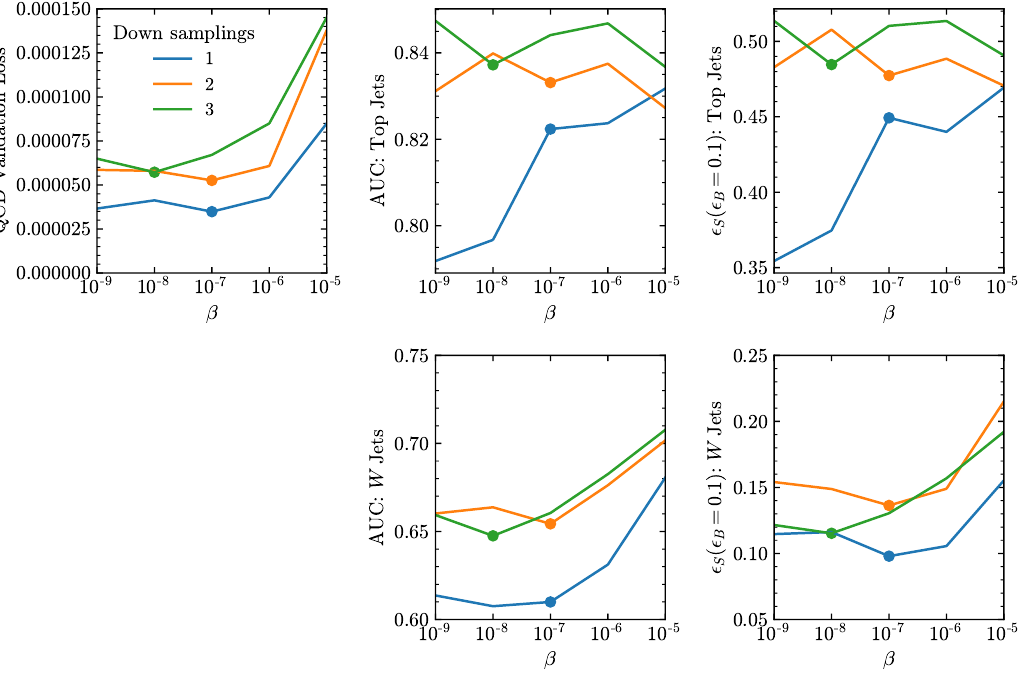
Figure 3 . Results from scanning over β . The value of β which minimizes the validation loss does not yield the highest AUCs or signal acceptence for fixed background rejection for either the top or W samples. If one were to use one of the signal samples to chose the value of β , it can lead to worse results on the other